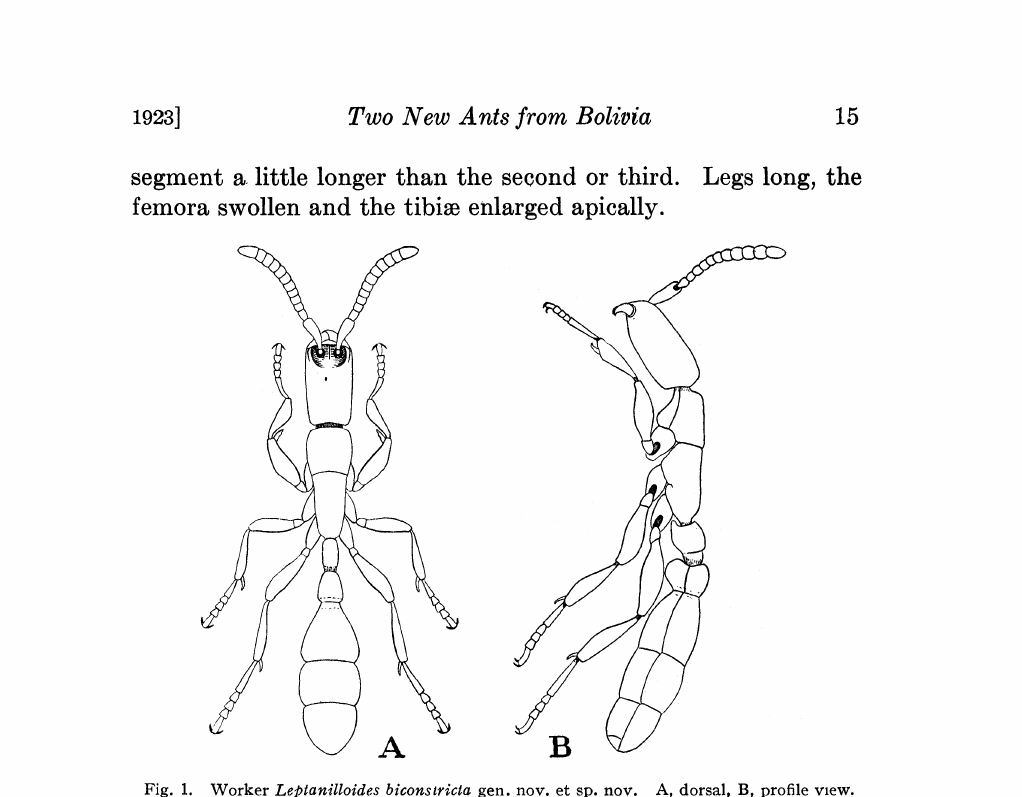
Fig. 1. Worker Leptanilloides biconstricta gen. nov. et sp. nov. A, dorsal, B, profile view. Shining; head with abundant, separated, coarse, punctures; thorax and abdomen, with much finer and sparser punctures. and erect, brownish